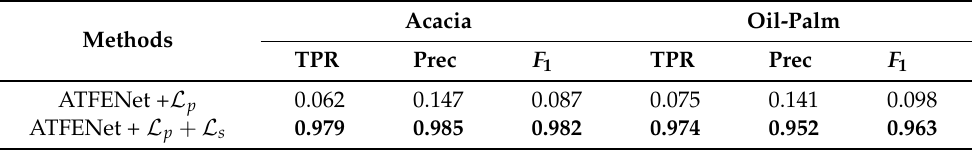
Table 4. Ablation study of the proposed algorithm for tree localization performance.